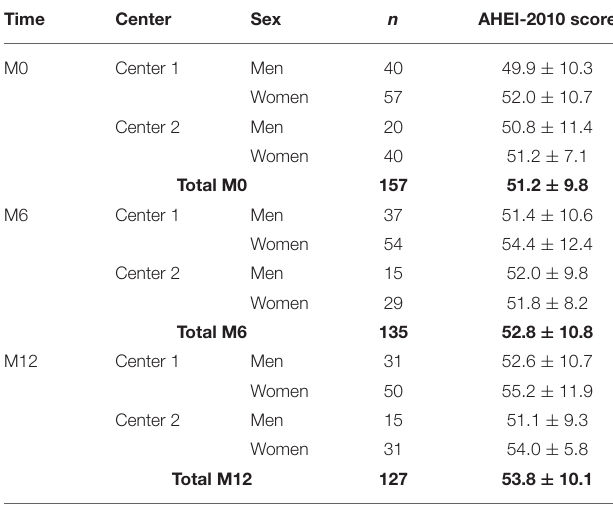
TABLE 1 | AHEI-2010 scores of the study population at the three study time points (M0, M6 and M12), divided by center and sex.